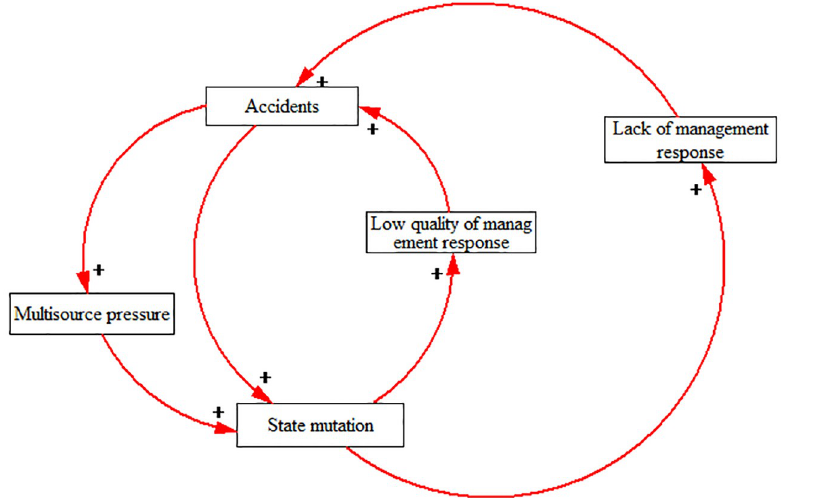
Fig 4. The occurrence mechanism of HATC